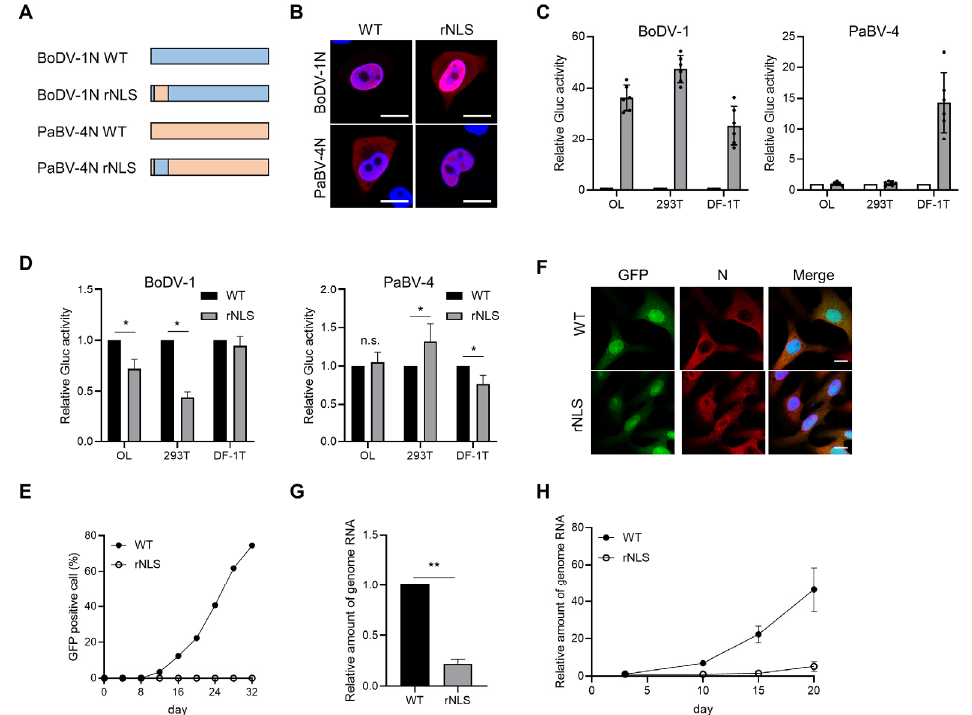
Figure 5. BoDV-1 N NLS enhances the polymerase activity of PaBV-4 in mammalian cells. ( A ) Schematic diagram of constructed chimeric N proteins. ( B ) Subcellular localization of chimeric N proteins in OL cells. The subcellular localization of each protein was assessed by confocal microscopy. Bars, 10 µ m. ( C ) BoDV-1 and PaBV-4 minireplicon assays. The minireplicon plasmid encoding Gaussia luciferase (Gluc) was co-transfected with helper plasmids into the indicated cell lines. Gluc activity was measured 72 h post transfection. The relative ratio of Gluc activity to that in negative control cells not transfected with the L expression plasmid is shown. ( D ) E ff ects of N-NLS substitution on the minireplicon activity of BoDV-1 and PaBV-4. The relative ratio of Gluc activity using chimeric N (rNLS) construct to that